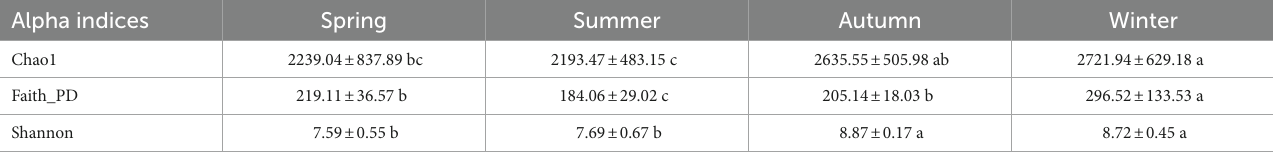
Values are represented as mean ± SD ( n = 27). Different lowercase letters within the same row indicate significant differences among different seasons (Kruskal-Wallis, p <